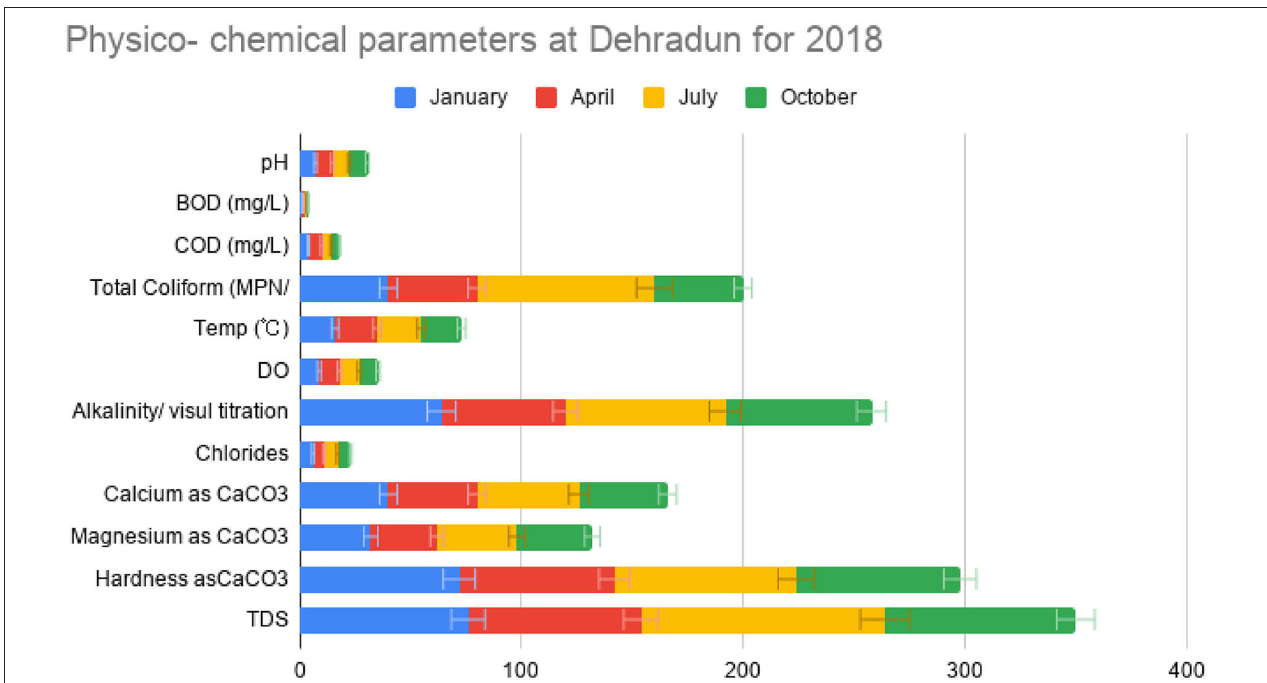
FIGURE 6 | Graphical representation of physicochemical parameters at Dehradun for 2018.